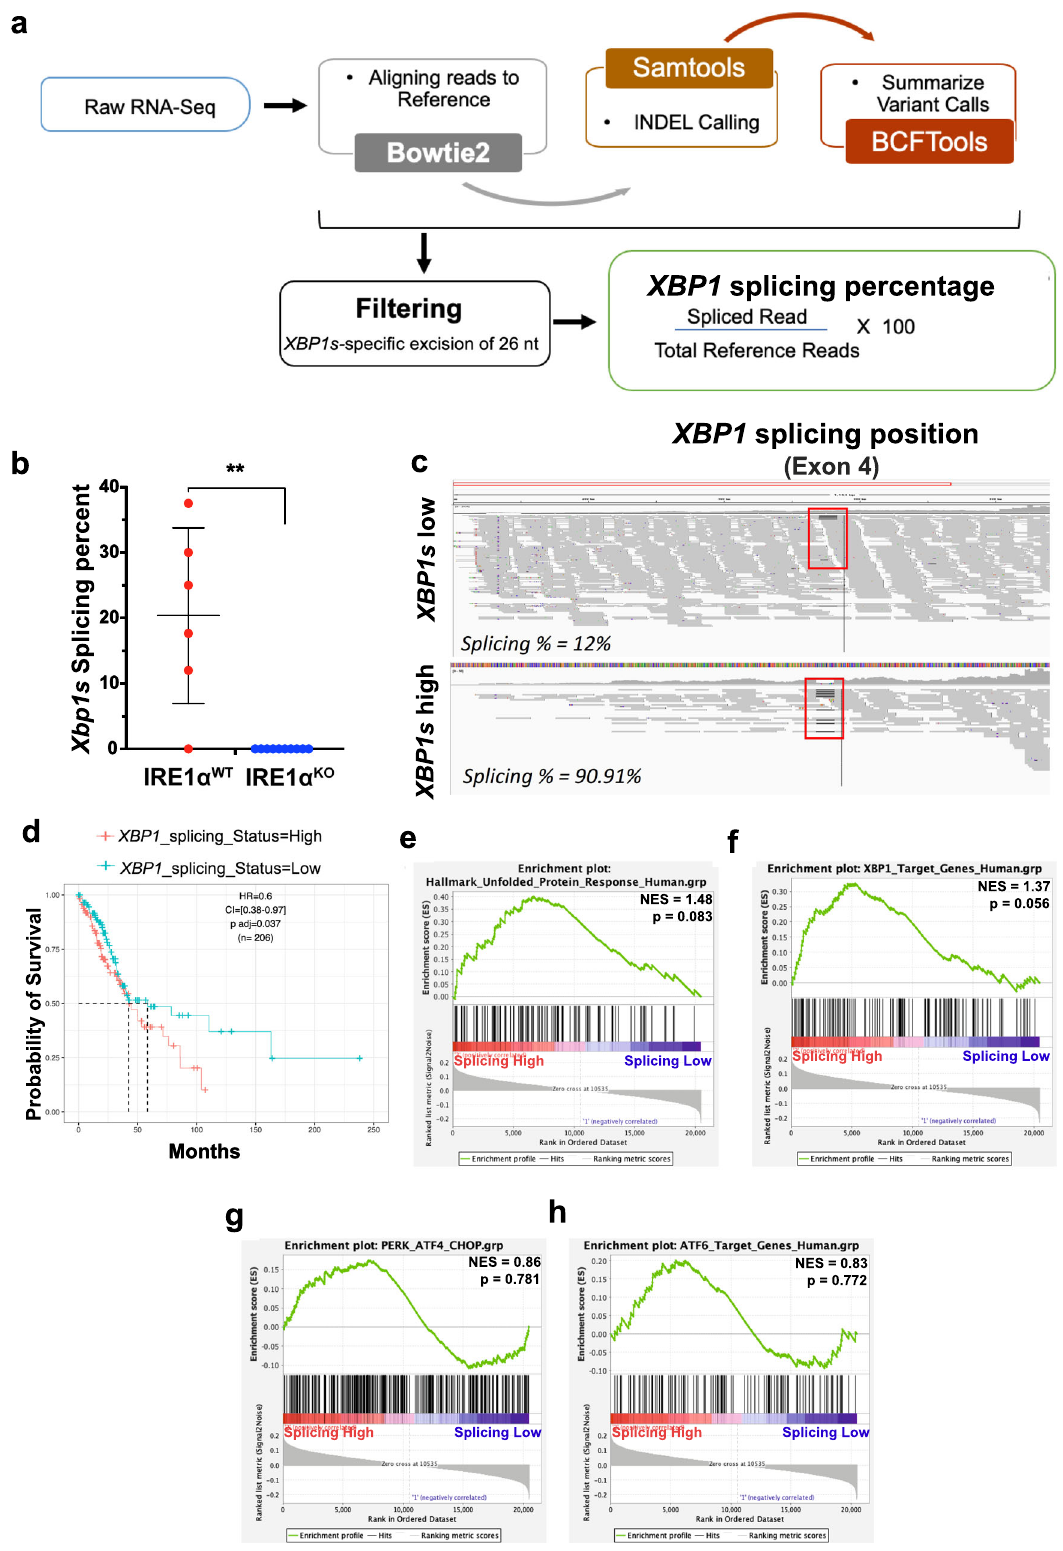
Fig. 1 | XBP1s is associated with decreased overall survival in human NSCLC. a SchematicoftheRNA-seqbased XBP1s detectionpipeline. b Boxandwhiskerplot of computationally evaluated Xbp1 splicing in isogenic IRE1 α WT (red, n =6) or IRE1 α KO (blue, n =10) HKP1 cancer cells. Data were presented as mean±SD. P <0.0002. Unpaired, two-tailed, Student ’ s t -test. c Visual survey of aligned reads using Integrative Genomic Viewer (IGV) showing detected indels including the 25 nucleotide excision of the XBP1 gene (red box). Representative XBP1s low and XBP1s high samples are shown. d Kaplan – Meier survival plots depicting